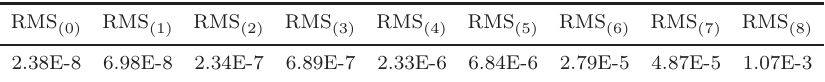
Table 4. Root-mean-square errors for example 2. Note:RMS ( i ) denote the root-mean square error of y ( i ) ,i = 0 , 1 , 2 ,..., 8